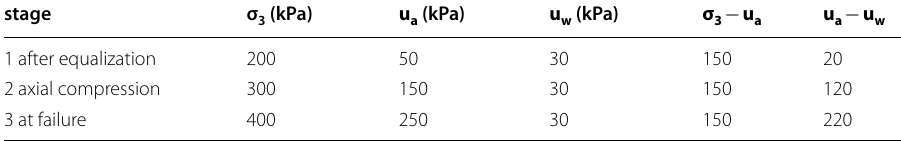
Table 3 Schematic stresses and matric suction for different stages in triaxial stress test stage